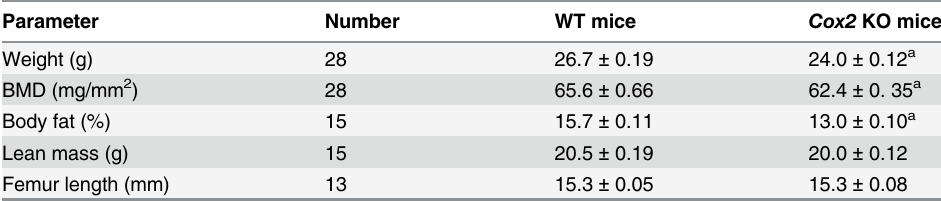
Table 2. Comparison of wild type (WT) and Cox2 KO